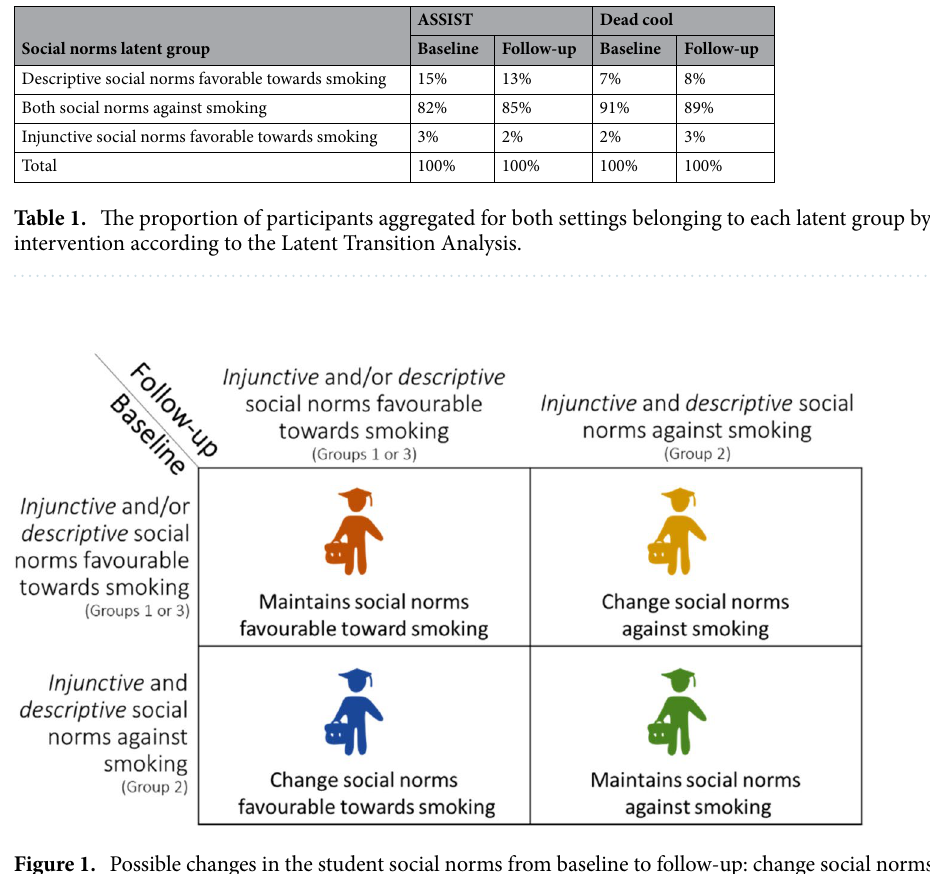
Figure 1. Possible changes in the student social norms from baseline to follow-up: change social norms to favorable towards smoking, change social norms to against towards smoking, maintain social norms favorable towards smoking, or maintain social norms against